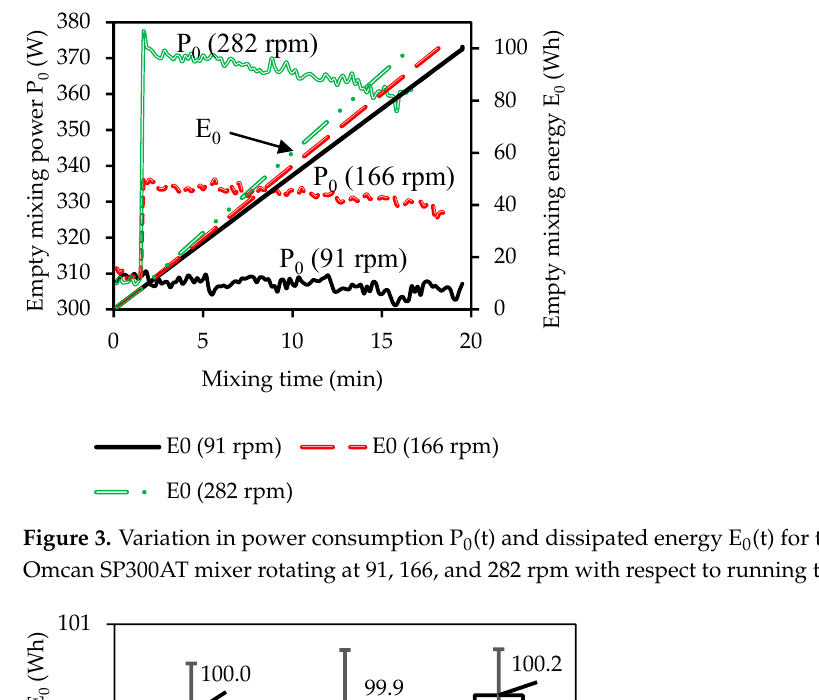
Figure 4. Validation of the mixing energy E 0 for the empty running Omcan SP300AT mixer: com- parison between calculated and measured values.